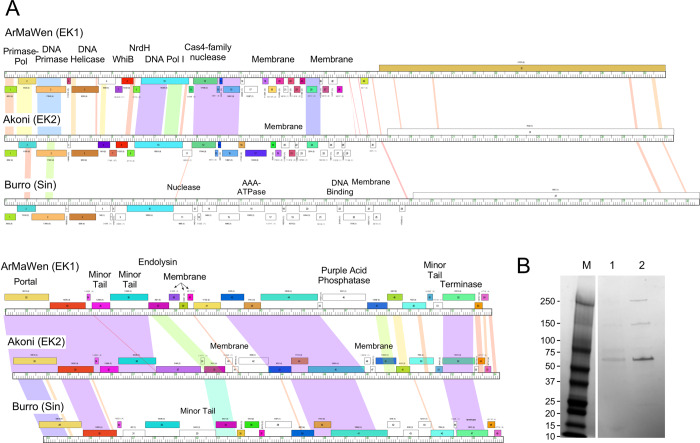
Microbacterium cluster EK phages and singleton burro.A. Genome organization of phages ArMaWen, Akoni and Burro, clusters EK1, EK2, and a singleton, respectively. See Fig 5 for details. B. SDS-PAGE of Burro virions. Lanes 1 and 2 correspond to Burro virions purified through one and two CsCl density gradients, respectively. M, marker with protein sizes indicated in kDa.